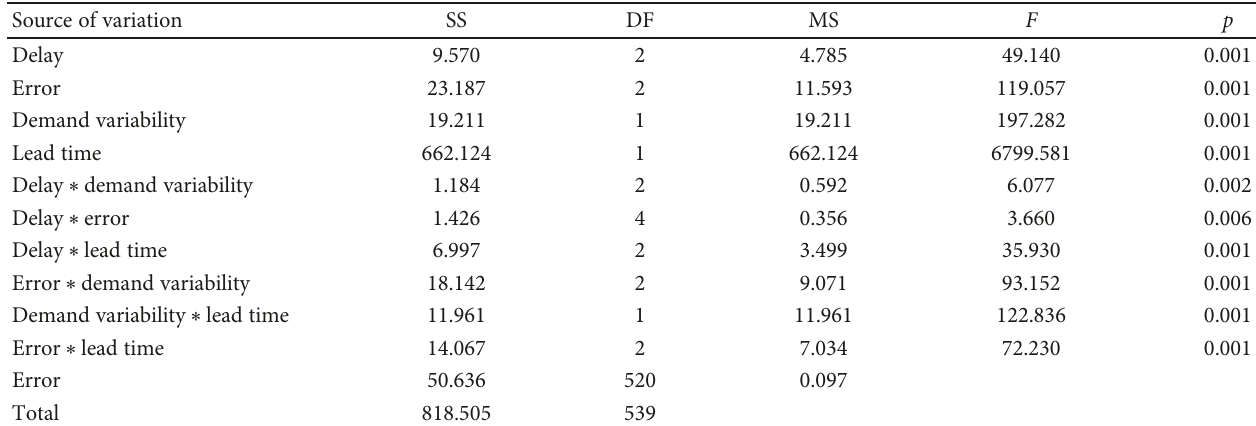
Table 7: ANOVA results for the bullwhip slope.